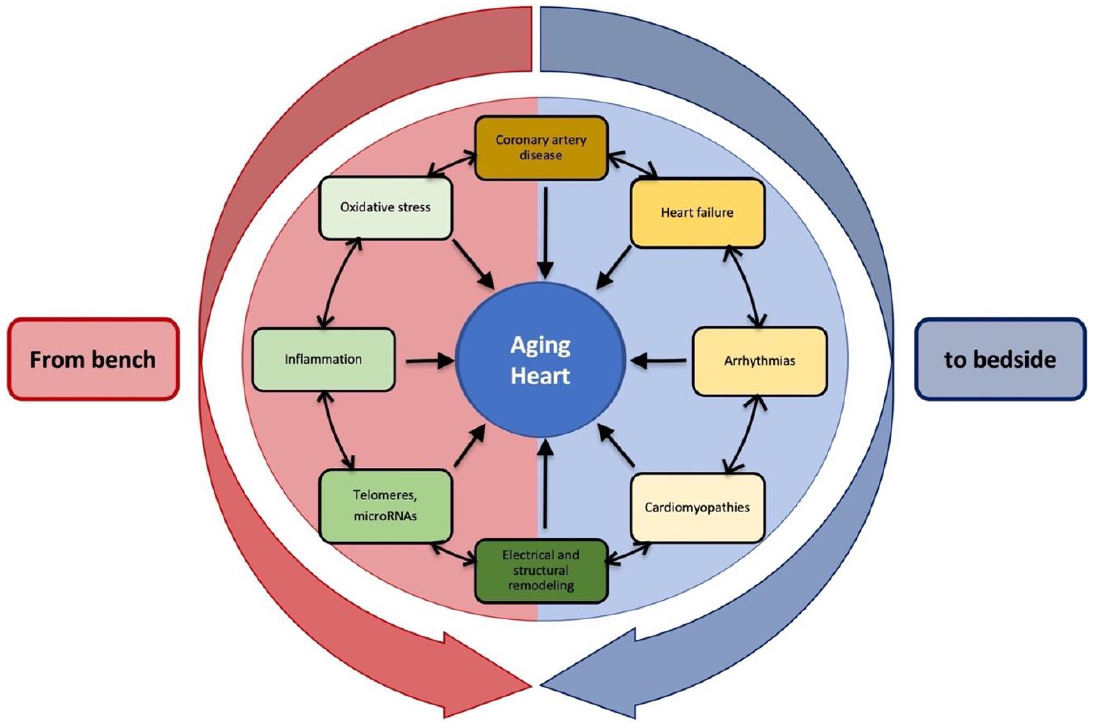
Figure 1. Aging heart: clinical and molecular features of cardiac conditions in older patients. Any of these items could contribute to cardiac aging individually or in combination.